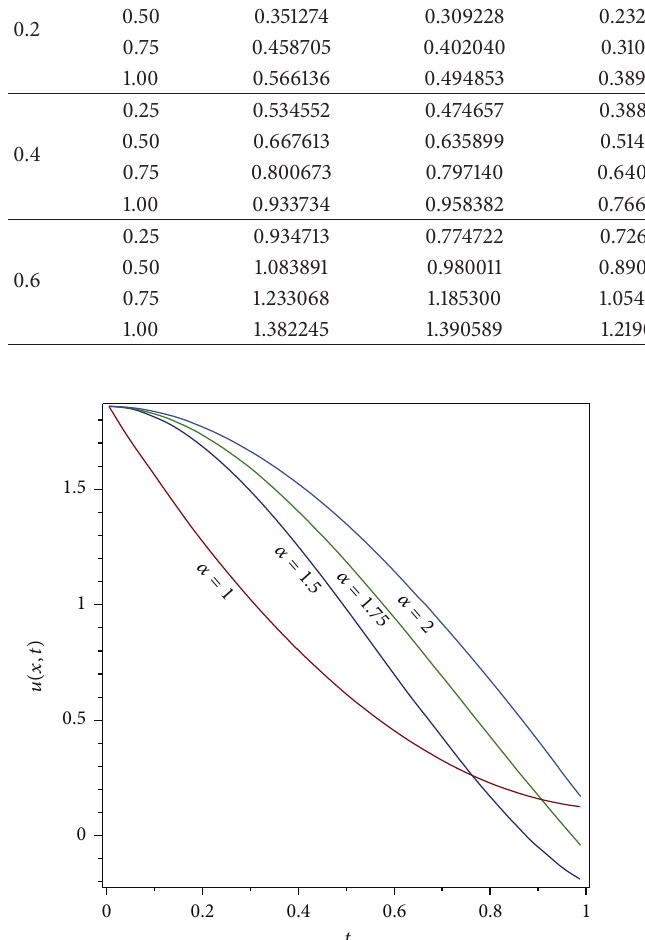
Figure 4: Plot of 𝑢(𝑥,𝑡) for various values of 𝑡 and different values of 𝛼 , 𝑥 = 1